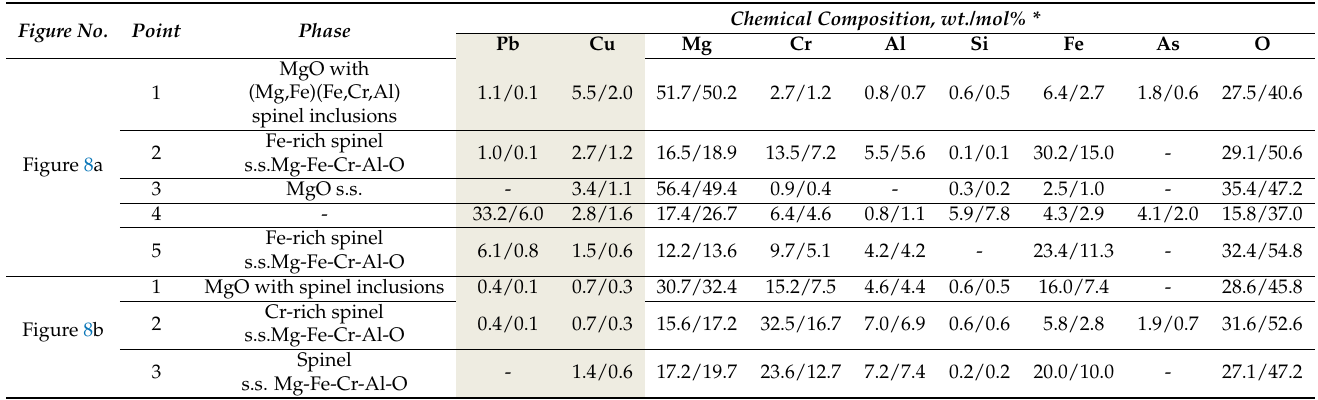
Table 7. EDS analysis in microareas of mixture FMC 57 + slag after corrosion, in the points marked in Figure 8, together with corresponding phases. Figure No.